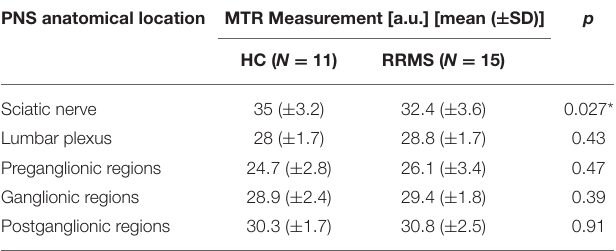
TABLE 3 | Summary of all MTR measurements in HCs and people with RRMS at each anatomical